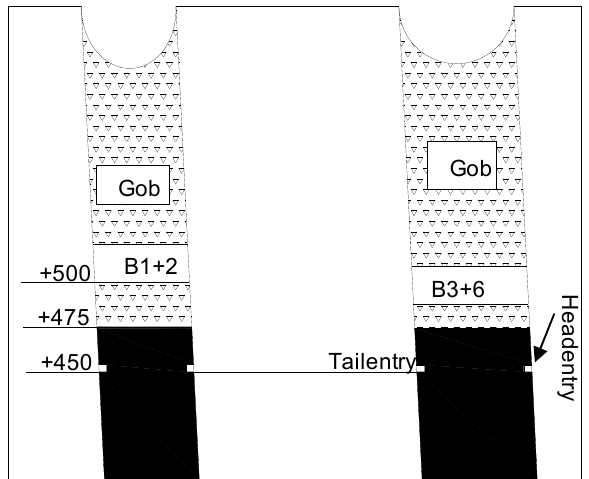
Figure 2. The section view of the coal seam (modified according to He et al. [39]. (Reproduced from [39], Elsevier: 2019.).